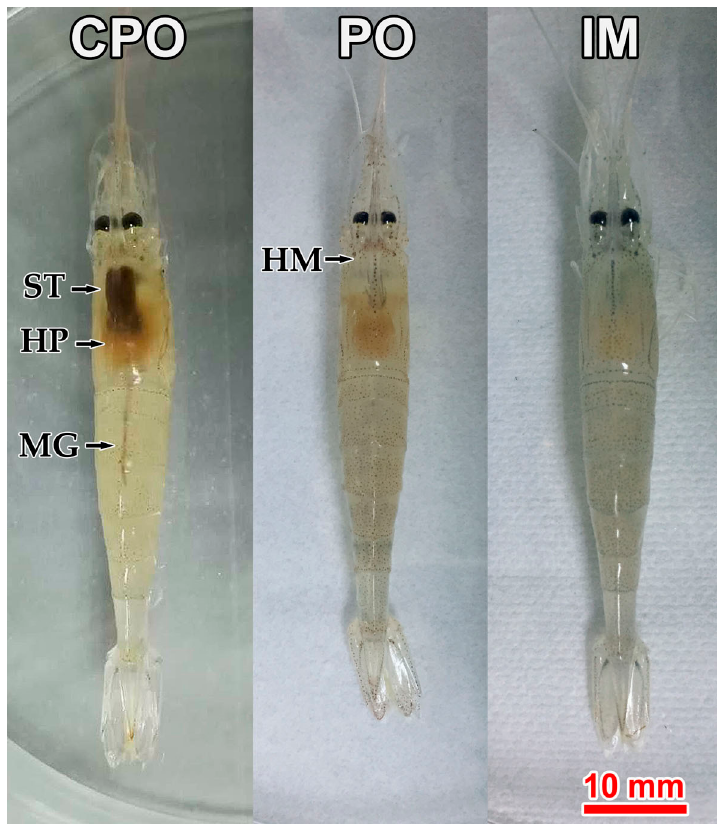
Figure 1. Gross signs of prawns Exopalaemon carinicauda in different groups of the challenge test. CPO: Prawn in per os control group; PO: Prawn in per os group; IM: Prawn in intermuscular injection group. Solid arrows indicate stomach (ST), hepatopancreas (HP), midgut (MG), and hematopoietic tissue (HM). Red bar = 10 mm.